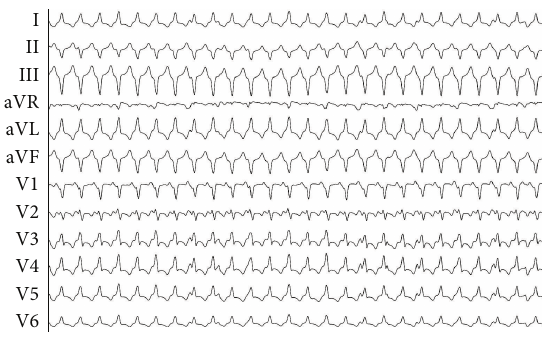
Figure 2: Reentrant ventricular